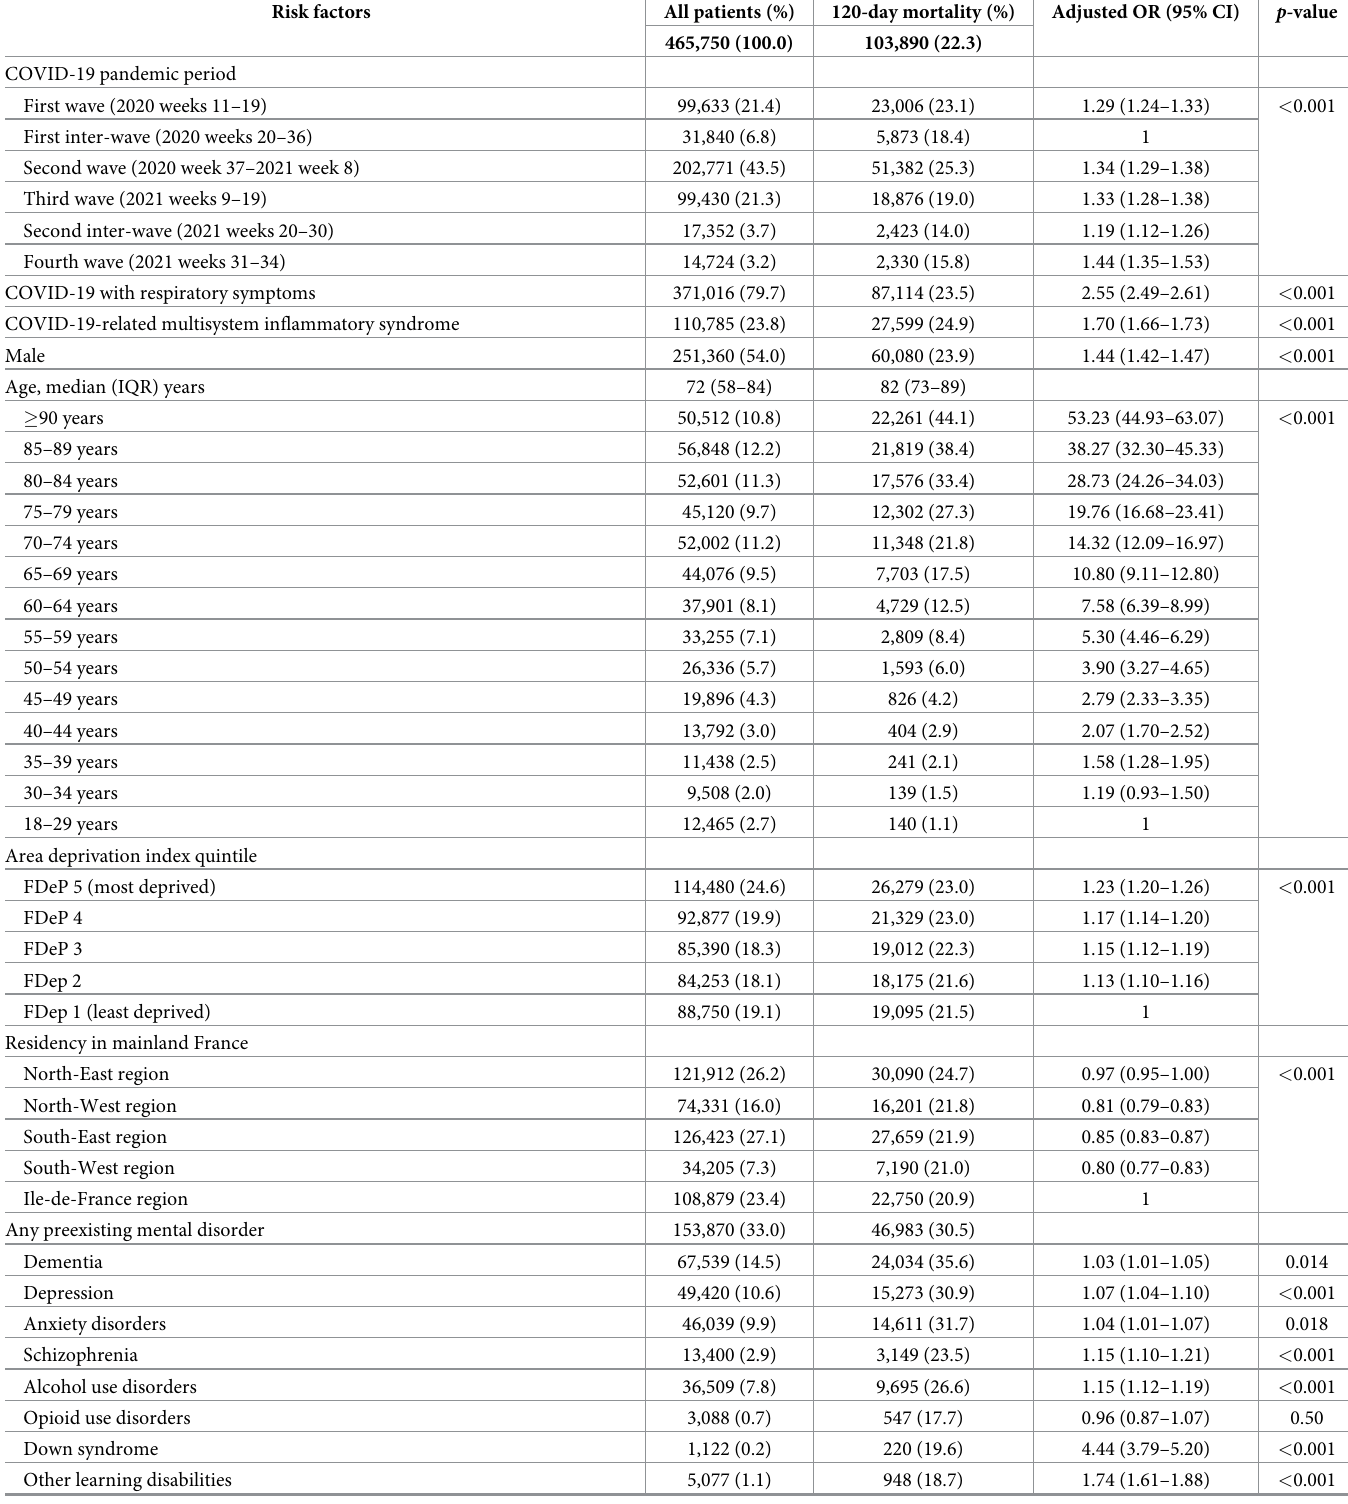
Table 1. Risk factors for 120-day mortality of inpatients with symptomatic COVID-19 in